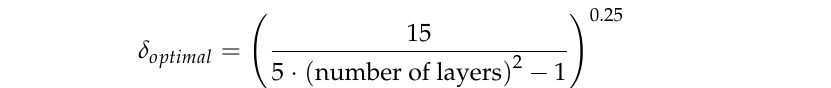
Figure 8. Copper losses inside a single slot with four conductors (excitation condition: 200 Apk/conductor at 500 Hz: ( a ) Copper losses vs. width, d = 3 mm; ( b ) Copper losses vs. height, W w = 3 mm.